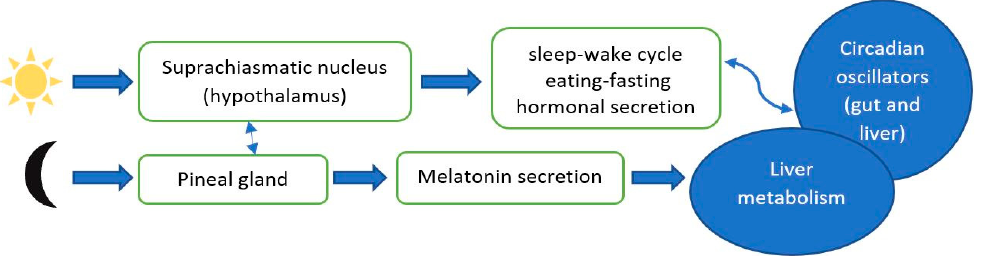
Figure 3. Schematic illustration of circadian rhythm.